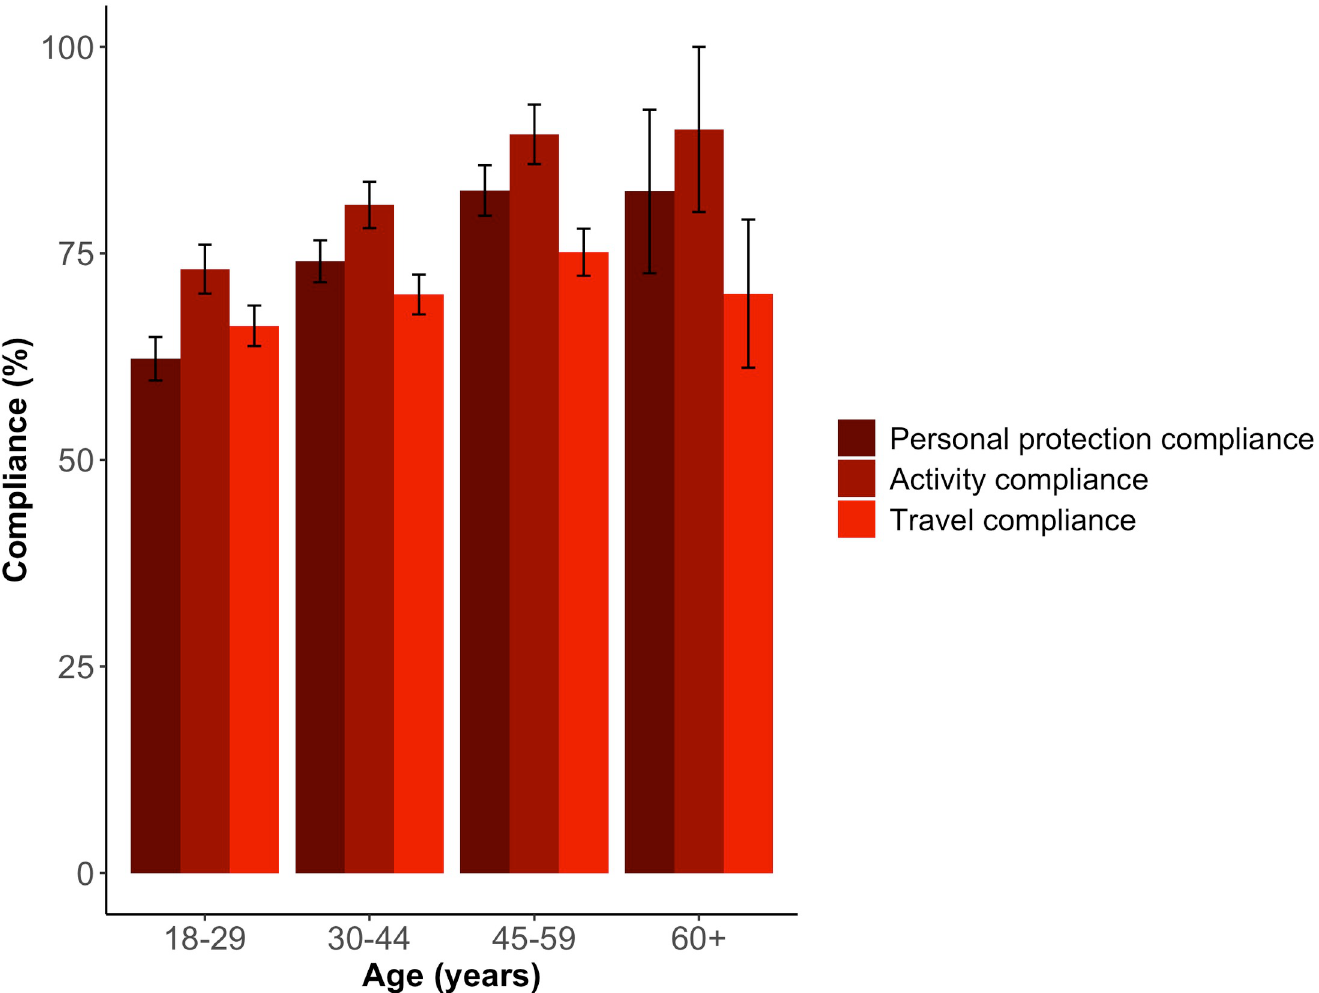
Fig 4. Mean compliance for each component by